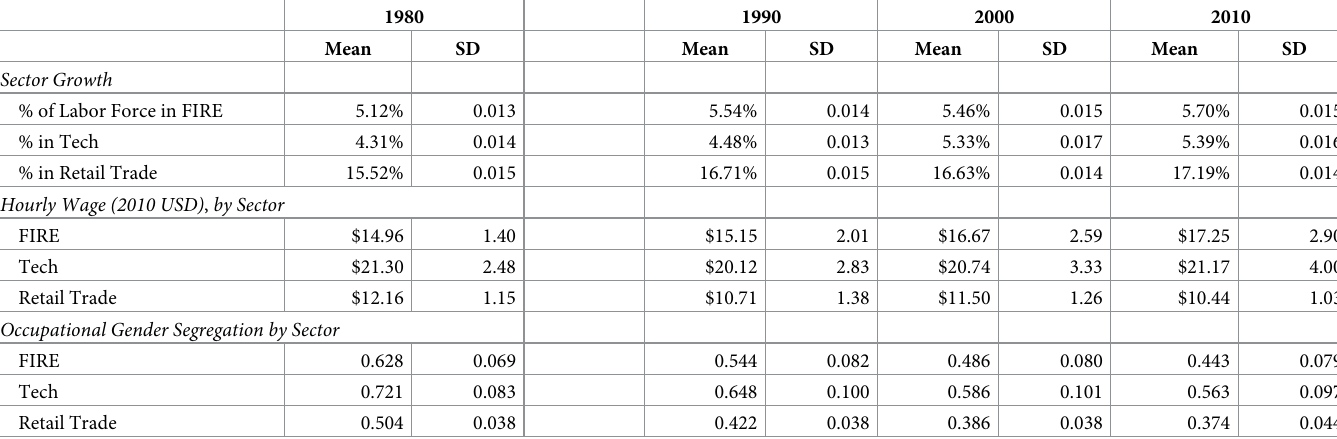
Table 1. Descriptive statistics of labor markets, 1980 to